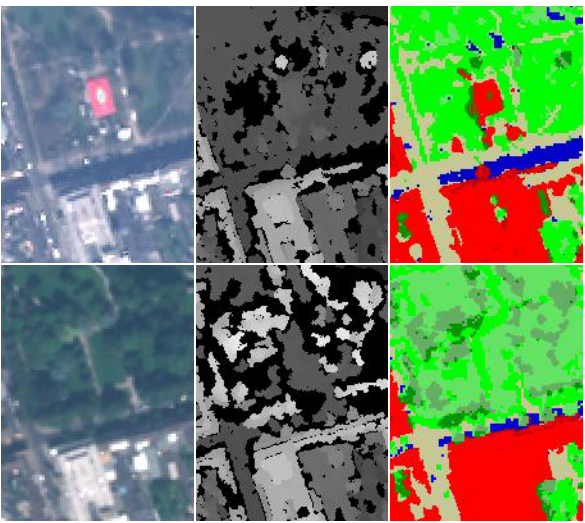
Figure 4: Ortho image, unfilled DSM and class map of the WorldView-2 (2011, top) and the GeoEye (2012, bottom) scenes (section 150 m × 200 m); Classes: red/dark red: high non-